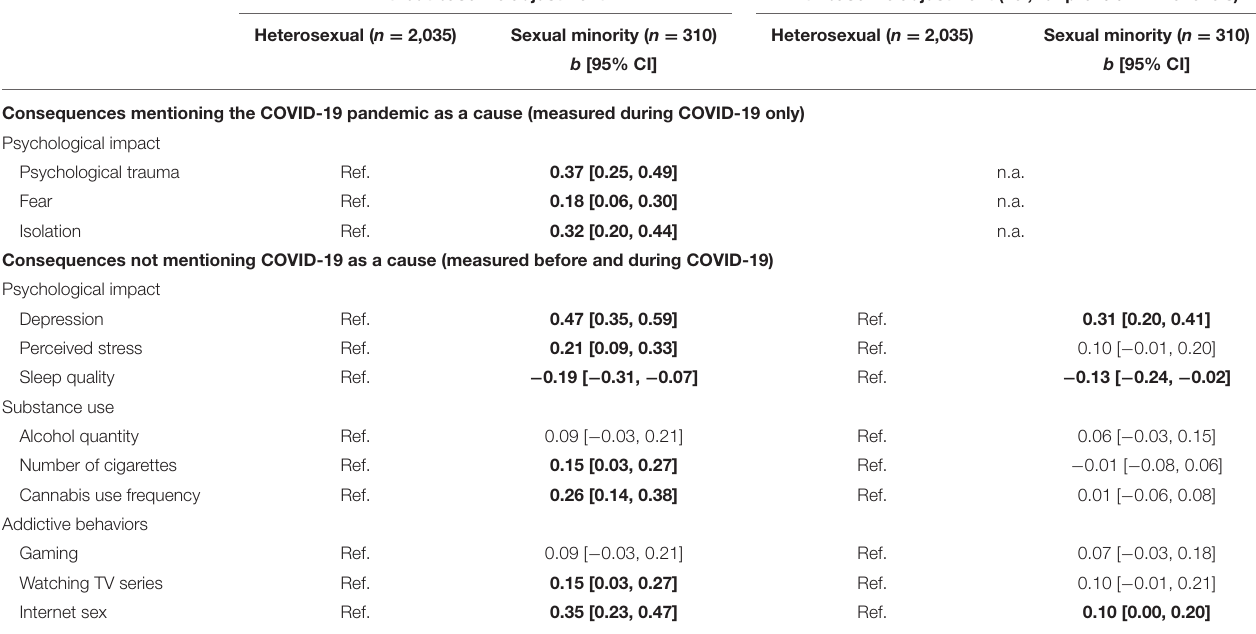
TABLE 3 | Sexual orientation [sexual minority vs. heterosexual (ref.)] as a predictor of the crisis’ psychological impact and its impact on substance use and addictive behaviors. Without baseline